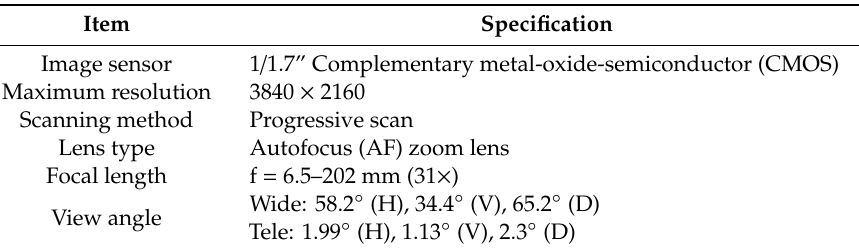
Table 1. Specification of CCTV [54].